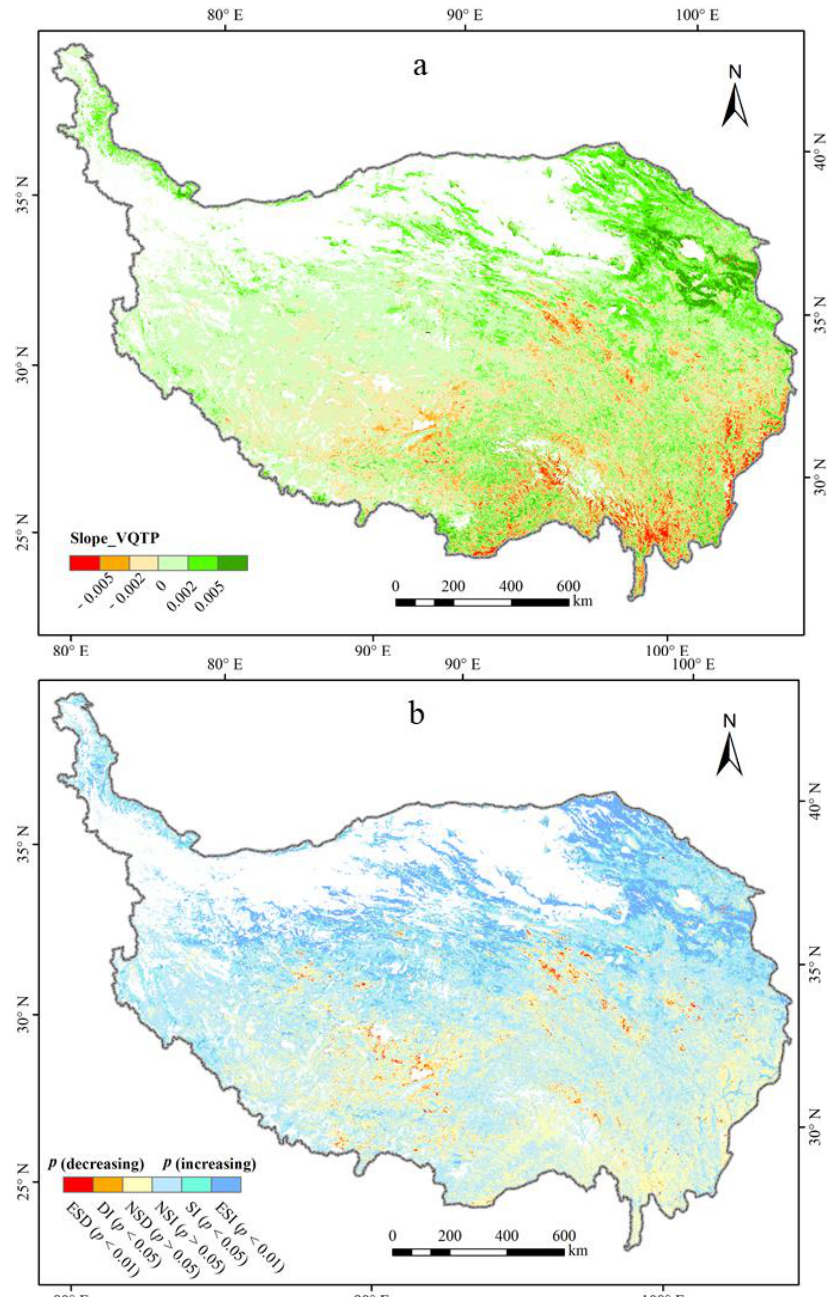
Figure 6. Spatial distribution of the NDVI slope ( a ) and significance level ( b ) in the Qinghai-Tibet Plateau (QTP) during the growing season from 2000 to 2018. p (decreasing) and p (increasing) are the p values of the decrease and increase for the growing season NDVI, respectively, which are divided into three levels: p < 0.01, 0.01 < p < 0.05, and p > 0.05.